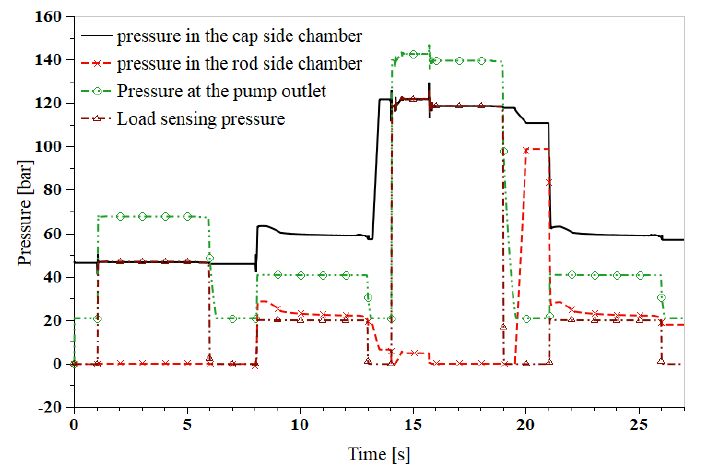
Figure 19. Boom cylinder and pump pressure curves of the proposed system with a fully loaded bucket.